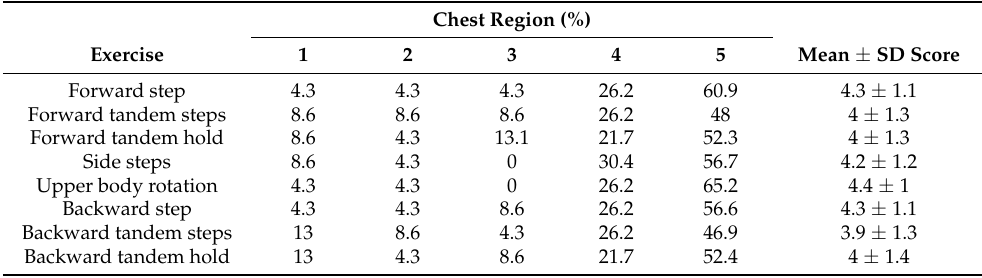
Table 4. Comfort scores of the exercises performed at the chest